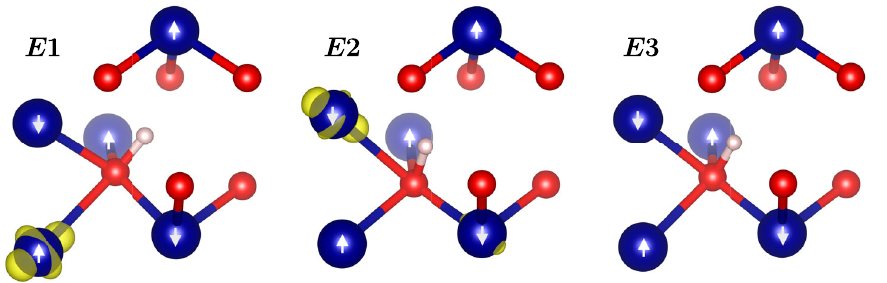
FIG. 9. Candidate muon stopping sites for E 1 − E 3 (white spheres) identified using DFT. Transparency indicates a location behind the solid atoms. Yellow isosurfaces indicate the spin density of the topmost occupied level ( d Arrows indicate direction of magnetic